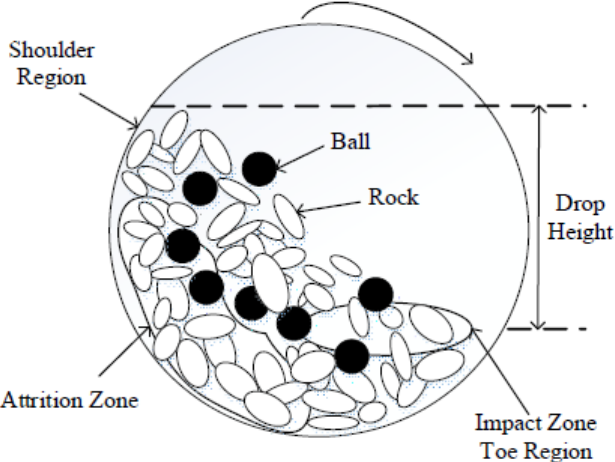
Figure 1. The schematic diagram of the working principle of a semi-autogenous (SAG) mill.